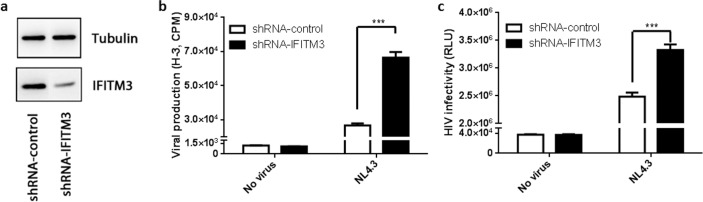
Knockdown of IFITM3 in gorilla fibroblasts decreases HIV-1 restriction.(a) Gorilla fibroblasts were transduced with a lentiviral vector containing a small hairpin RNA (shRNA) against IFITM3 or a control shRNA (non-specific). Knockdown efficiency of IFITM3 was determined by Western blot. Tubulin was used as a loading control and IFITM3 was detected using αnti-IFITM3. (b and c) Gorilla fibroblasts containing shRNAs were infected with HIV-1 NL4.3-VSV-G. At 48 hours post-infection, newly produced viral supernatants were measured for infectious particles by infecting HeLa-TZM-bl indicator cells (b) or measured for reverse transcriptase activity (c). Averages and standard errors were determined from three independent experiments (* indicates a p-value < 0.05).